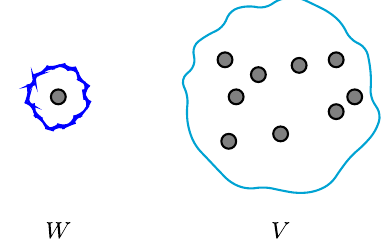
Fig. 2 Local structure of the total system and the choice of subsystems in the 4-point OTOC. W is an operator on a small local subsystem,